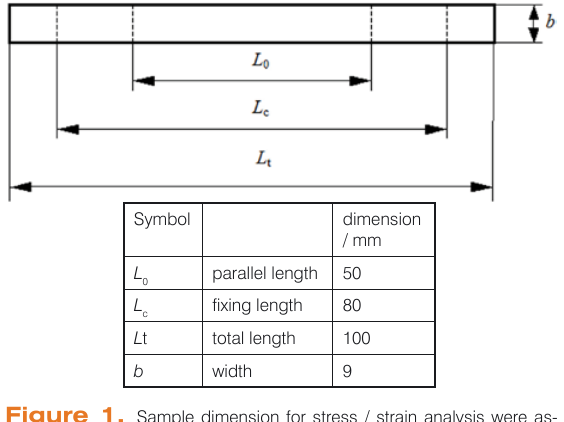
Figure 1. Sample dimension for stress / strain analysis were as- signed on the cold worked metal tapes.